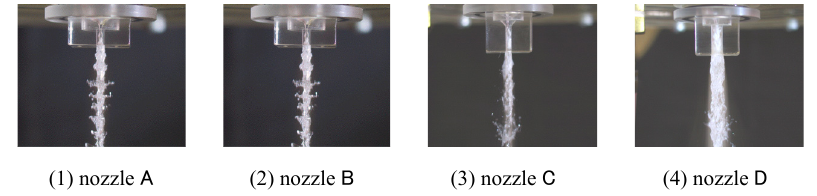
Fig. 3 Behavior of air-water jets with exposure time=15 μ s and P a